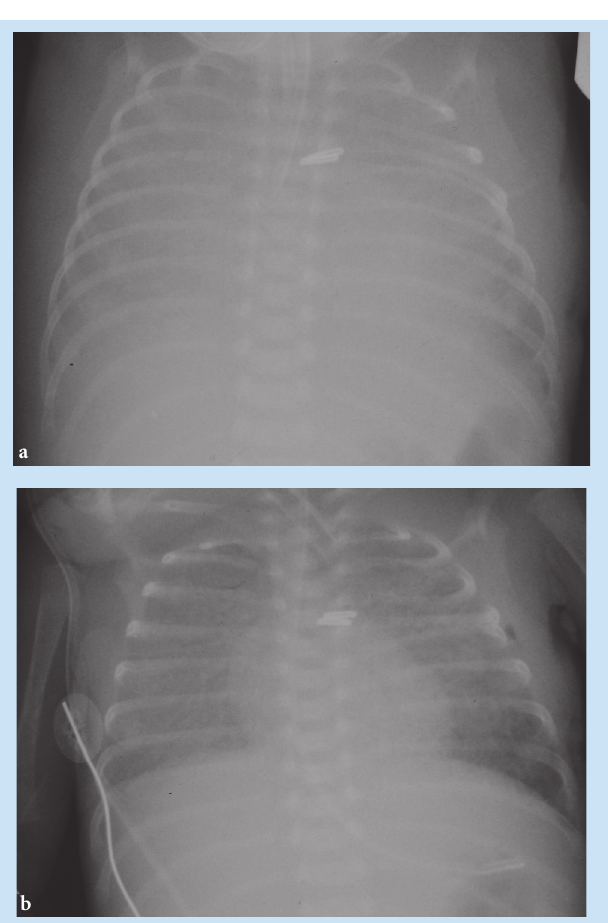
Figs. 22 (a) and (b). Cardiac failure. Complete white out of the lung paren- chyma bilaterally in a patient who has features of previous cardiac surgery (PDA clips and thoracotomy changes on the left). After fluid restriction the patient demonstrates re-appearance of the cardiac and diaphragmatic margins consistent with some resolution of the pulmonary oedema.